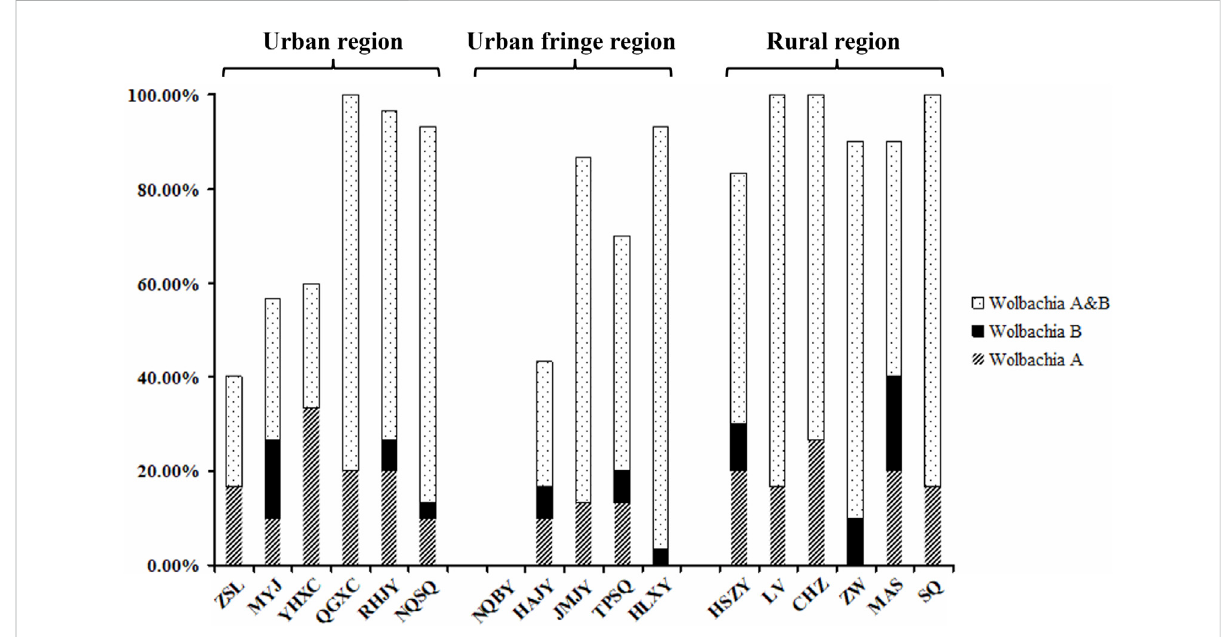
FIGURE 6 Independent infection rate of Wolbachia A and Wolbachia B among different Ae. albopictus populations from urban, urban fringe, and rural areas of Nanjing